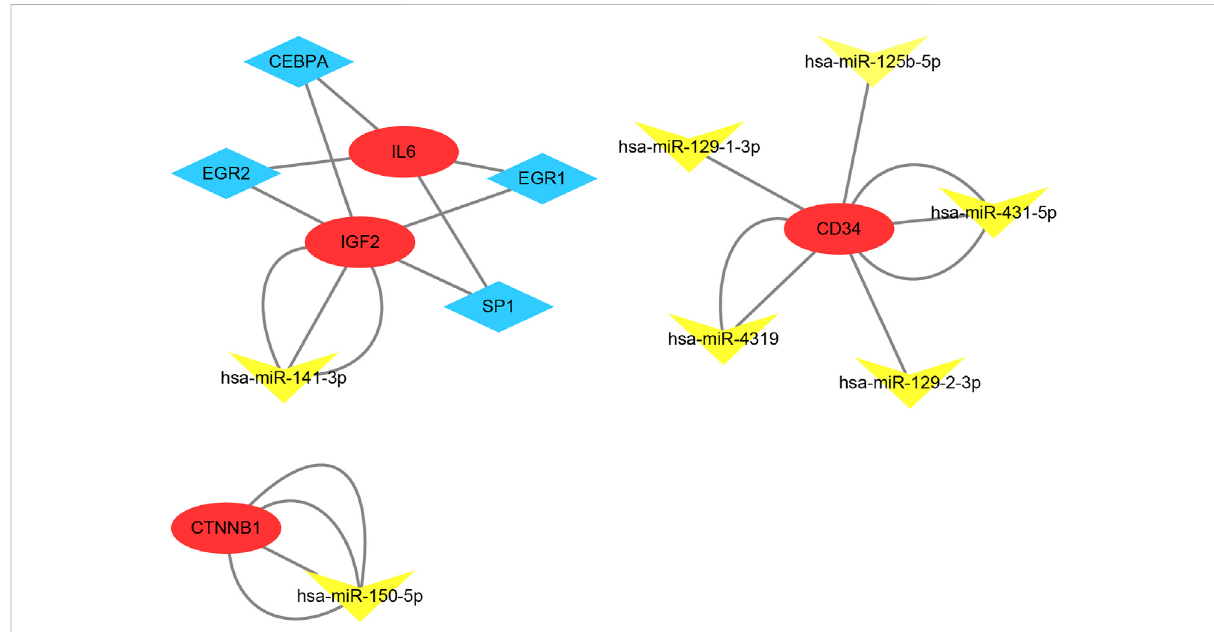
FIGURE 7 TF-mRNA-microRNA regulatory network. Red circles represent hub genes, blue diamonds represent transcription factors and yellow triangles represent